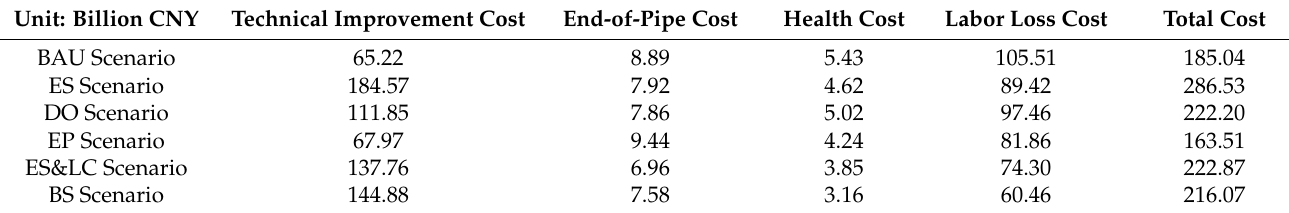
Table 5. Cumulative costs of the five scenarios for 2015 to